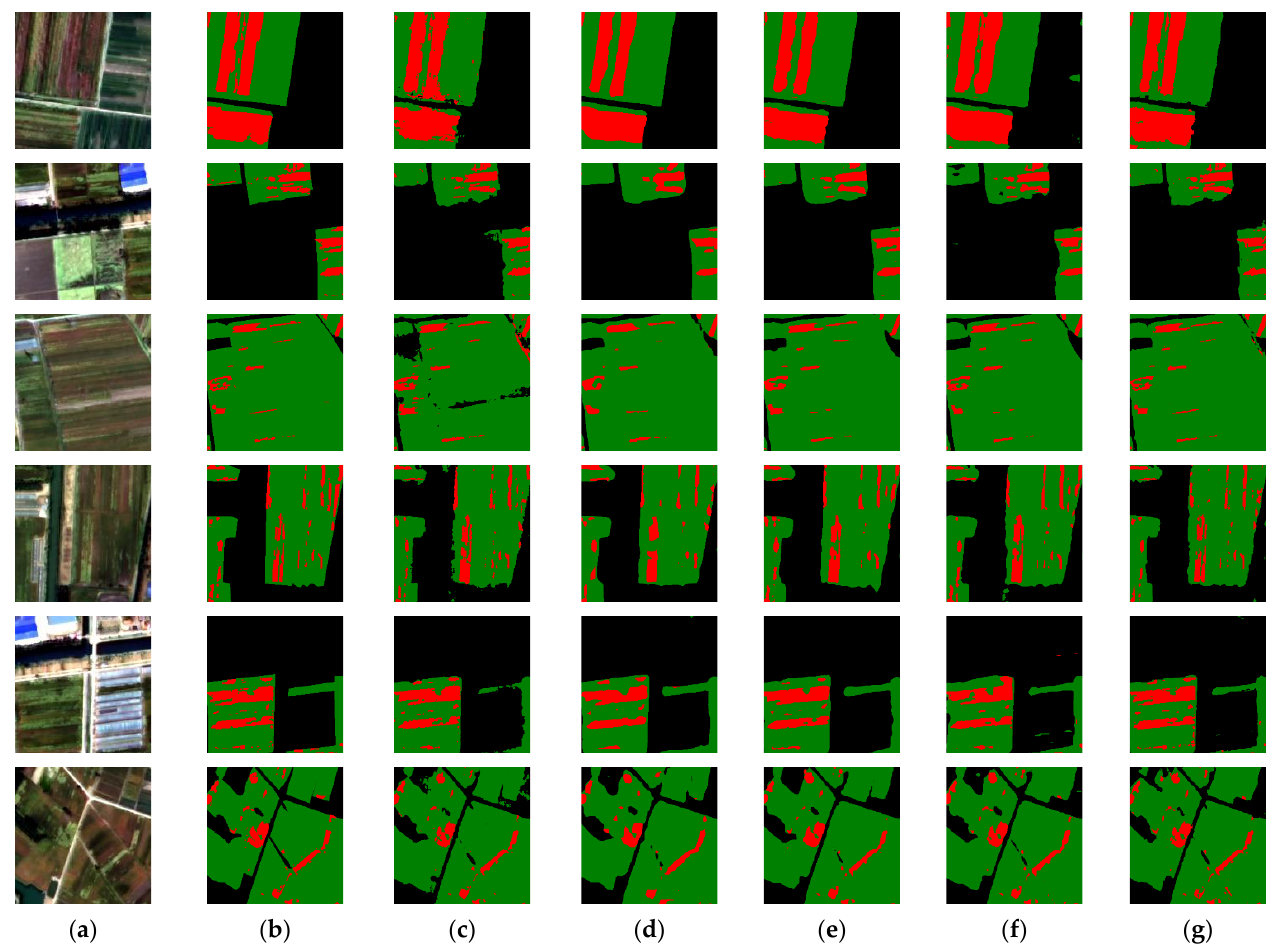
Figure 13. Segmentation results comparison on the test dataset: ( a ) original image in test dataset; ( b ) ground truth; ( c ) SegNet; ( d ) PSPNet; ( e ) FPN; ( f ) DeepLabv3+; ( g ) PTCNet.